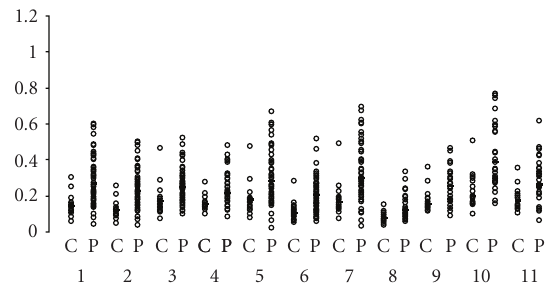
Figure 2: Scattergrams represent the OD values for AD patients (P) and controls (C) for each conjugate (statistically significant) and isotype (statistically significant). The first lane of OD values corresponds to C and the second to P. IgA for: (1) 3-OHKyn, (2) Kyna, (3) Quina, (4) 3-OHAnthra, (5) Anthra, (6) Xantha, (7) Pico, (8) 5-HT, (9) Mel, (10) 5-HIAA, and (11)